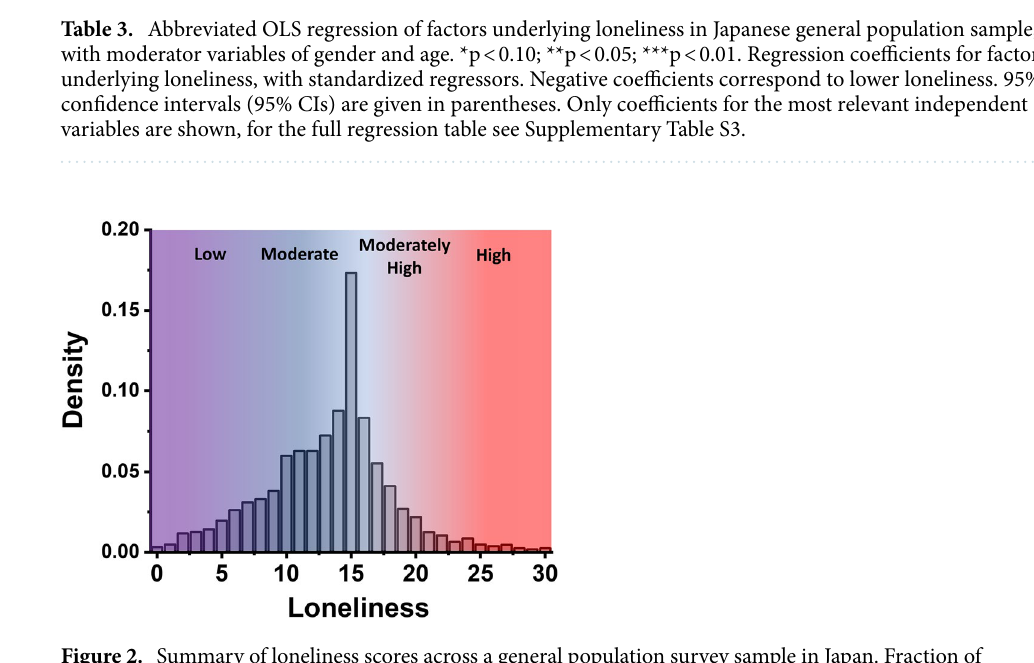
Figure 2. Summary of loneliness scores across a general population survey sample in Japan. Fraction of the respondents with each possible loneliness score. Loneliness was calculated based on the SF-10 loneliness scale, with ten 4-point questions and a total range of 0–30 points, and higher scores representing higher loneliness. Overlaid are approximate positions of four typical loneliness scoring categories of “Low”, “Moderate”, “Moderately High”, and “High” that are often used in the SF-20 loneliness scale (not used in this work), which has a score range of 0–60. In the SF-20 scale, 0–14 denotes a low degree of loneliness, 15–29 a moderate degree of loneliness, 30–44 a moderately high degree of loneliness, and 45–60 a high degree of loneliness. Thus, approximate scoring boundaries within the SF-10 scale that was used in this study would be 0–7 (low), 7.5–14.5 (moderate), 15–22 (moderately high), and 22.5–30 (high). No official categorization exists yet in the SF-10